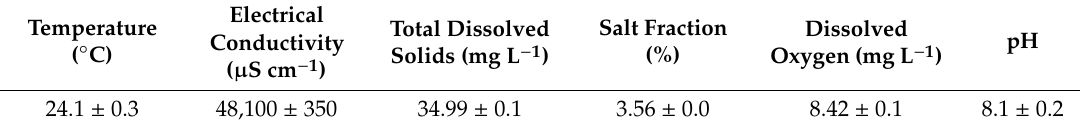
Table 1. Physicochemical parameters of seawater